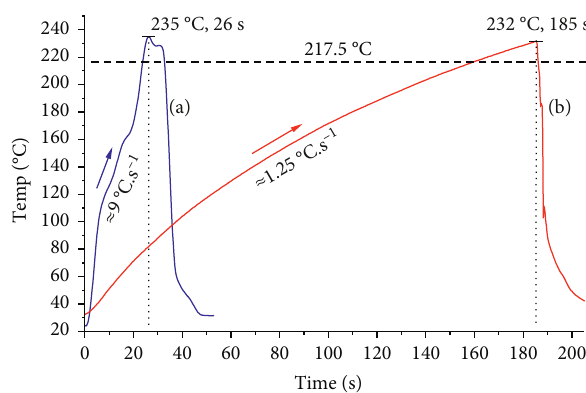
Figure 2: Time-temperature profiles of SAC alloy soldered by induction heating (a) and heat conductive reflow soldering method (b). 217.5 ° C is solidus temperature of solder